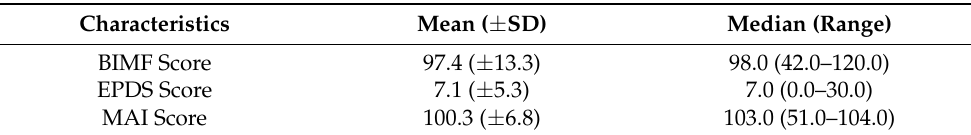
Table 1. Maternal functioning and clinical characteristics of Black postpartum mothers living in Georgia, February–April 2020 ( n = 116).